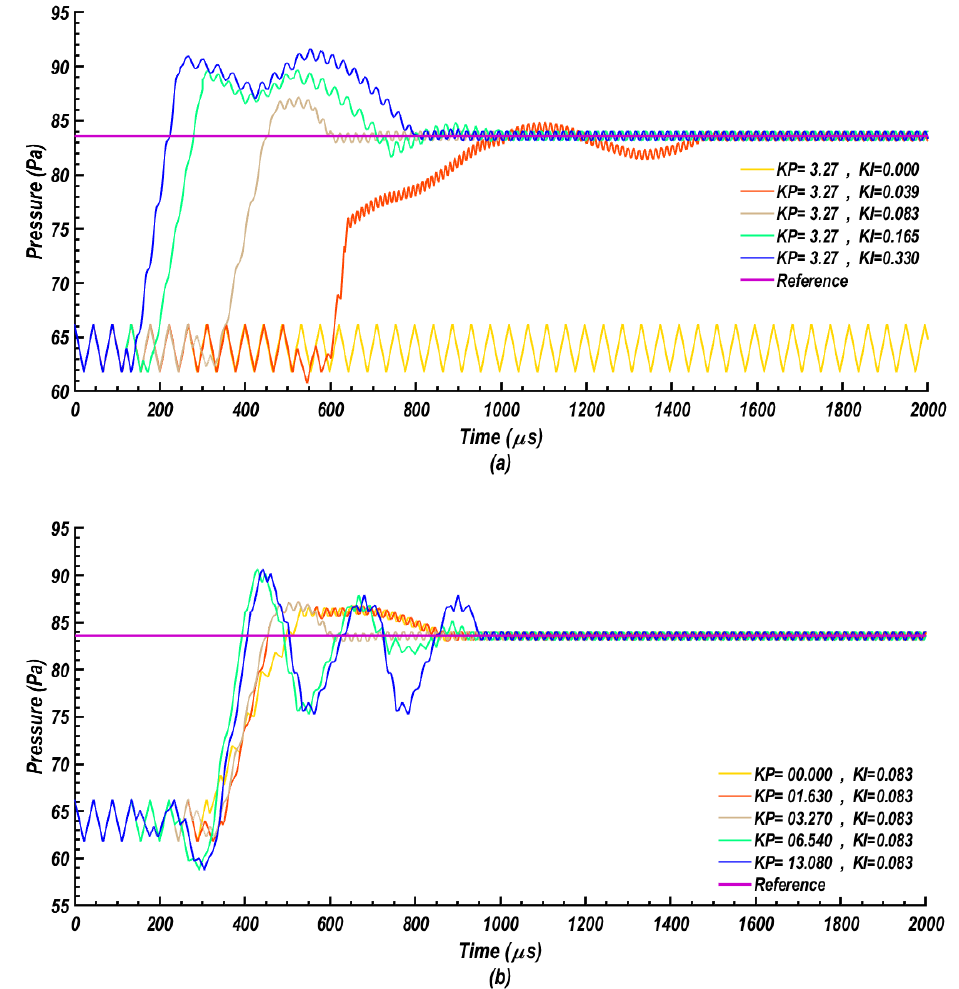
Figure 20. Closed-loop step responses for PI controller for cases with ( a ) KP = 3.27 & various values of KI [0–0.330], and ( b ) KI = 0.083 and various values of KP [0–13.080].